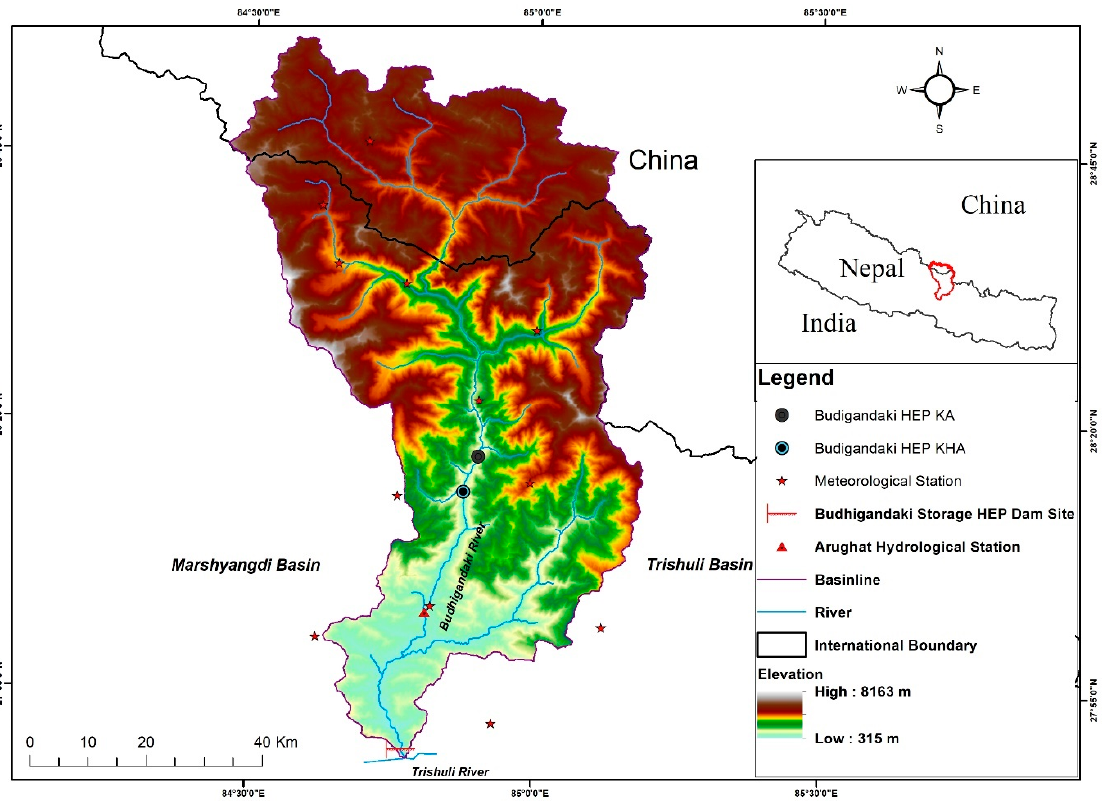
Figure 1. Location map of the Budhigandki River Basin.